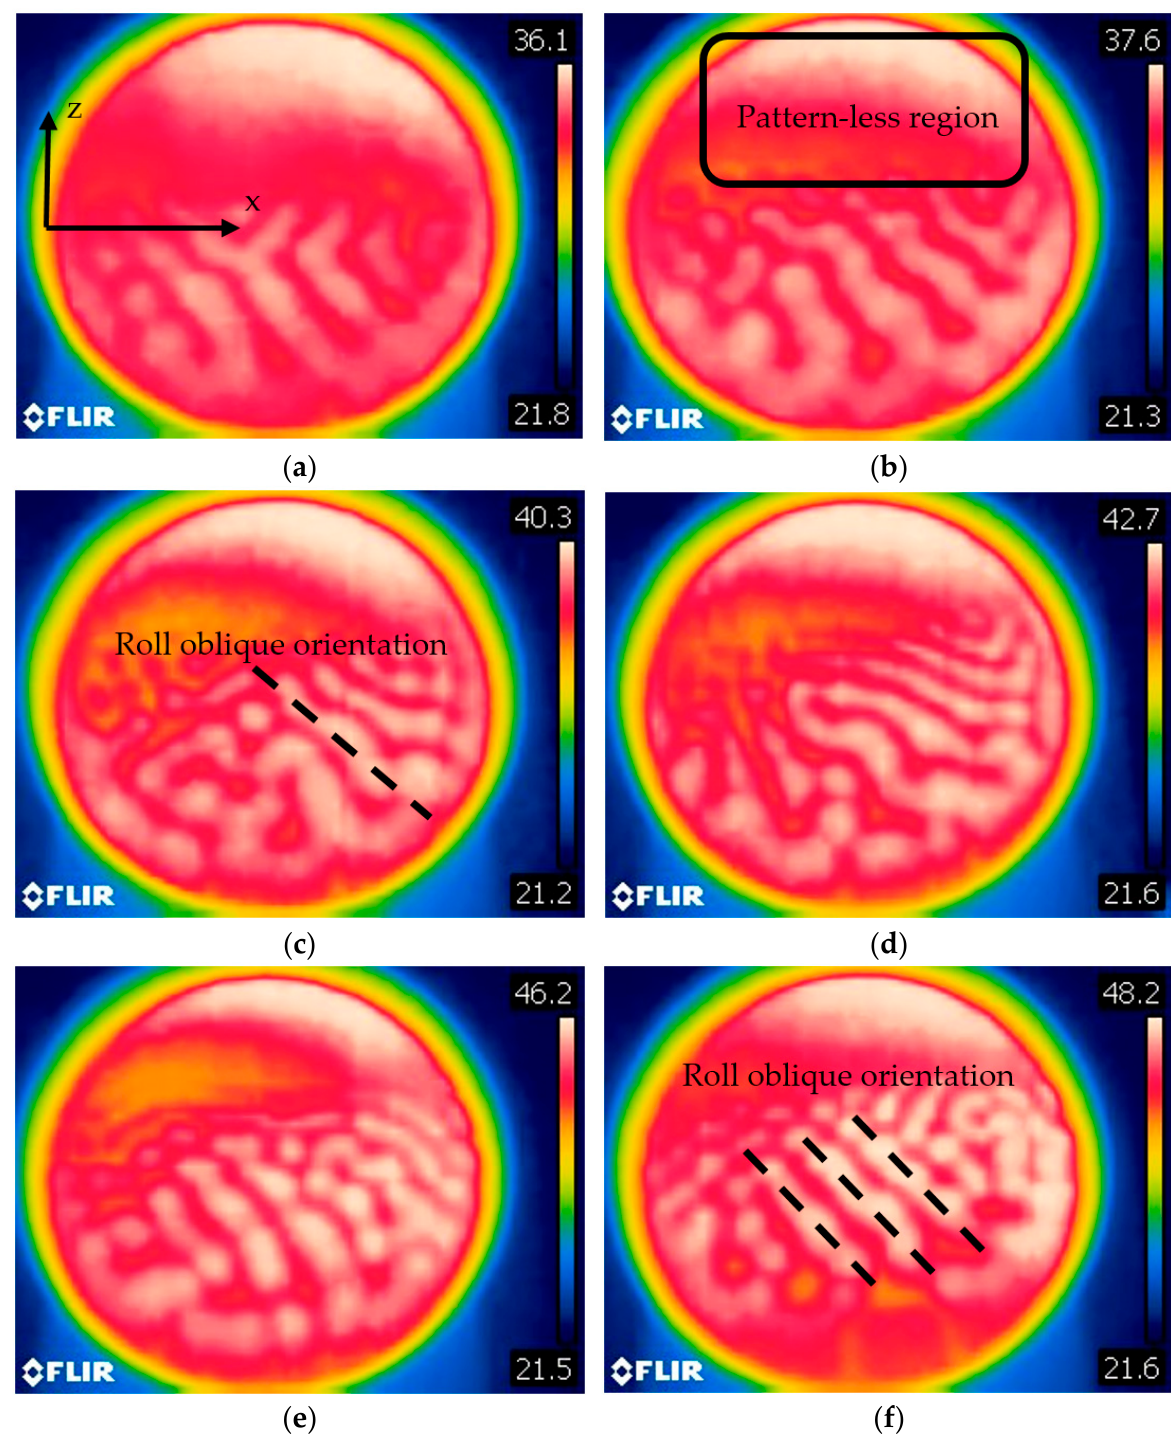
Figure 14. Surface temperature distribution for d = 0.50 cm ( Ω ≅ 70 mL) and ϑ ≅ 3.5° ( A = 26.6, Bo dyn ≅ 0.86, Ra ≅ 2.5 × 10 2 × ∆ T , Ma ≅ 2.94 × 10 2 × ∆ T ): ( a ) ∆ T = 15 °C, ( b ) ∆ T = 18 °C, ( c ) ∆ T = 21 °C, ( d ) ∆ T = 24 °C, ( e ) ∆ T = 27 °C, ( f ) ∆ T = 30 °C (the x and z axes correspond to the horizontal and vertical directions in all the panels).